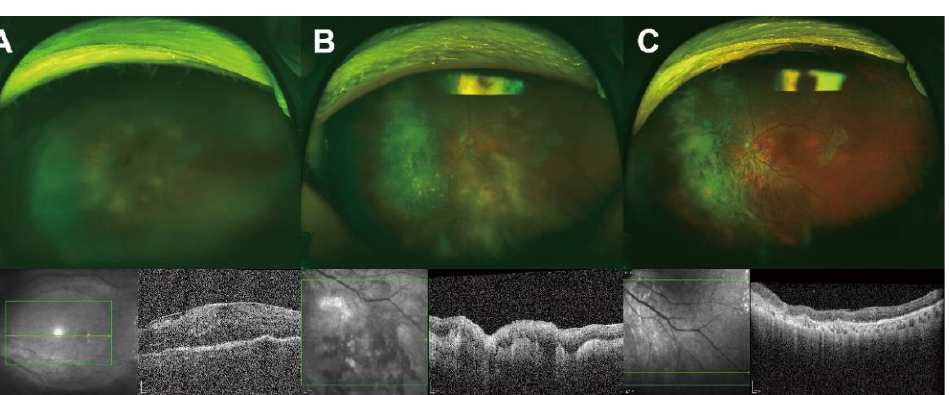
Figure 1. Representative ocular findings before and after diagnostic vitrectomy. A 75-year-old woman visited the outpatient clinic with a complaint of decreased visual acuity in her left eye that began 3 months prior to presentation. She was receiving oral prednisolone for chronic uveitis. At the first examination, the visual acuity was 20/200 and the intraocular pressure was 11 mmHg. Slit-lamp examination revealed inflammatory cells in the anterior chamber and vitreous cavity. ( A ) Funduscopic examination revealing vitreous opacity with multifocal, subretinal, yellowish granular infiltration. Optical coherence tomography (OCT) images showing the epiretinal membrane, dense infiltration of the sub-retinal pigment epithelium (subRPE), lumpy-bumpy choroid, subretinal fluid, and intraretinal fluid. Following these findings, a diagnostic vitrectomy was performed. ( B ) After diagnostic vitrectomy, a yellowish subretinal infiltration was clearly visible, and subRPE infiltration and lumpy-bumpy choroid were also visible on OCT images. Accurate diagnosis with vitreous cy- tology was not possible due to cellular paucity; however, a diagnosis of vitreoretinal lymphoma was confirmed through an IGK gene clonality assay. ( C ) The lesions improved after four injections of intravitreal methotrexate.